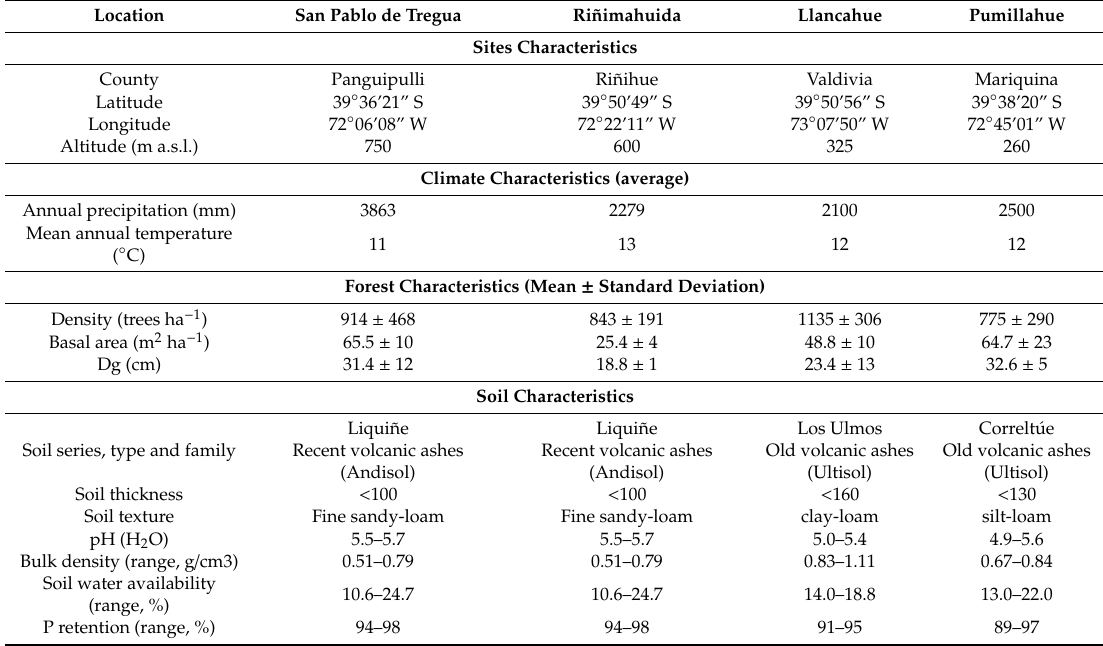
Table 1. General characteristics of the experiment and